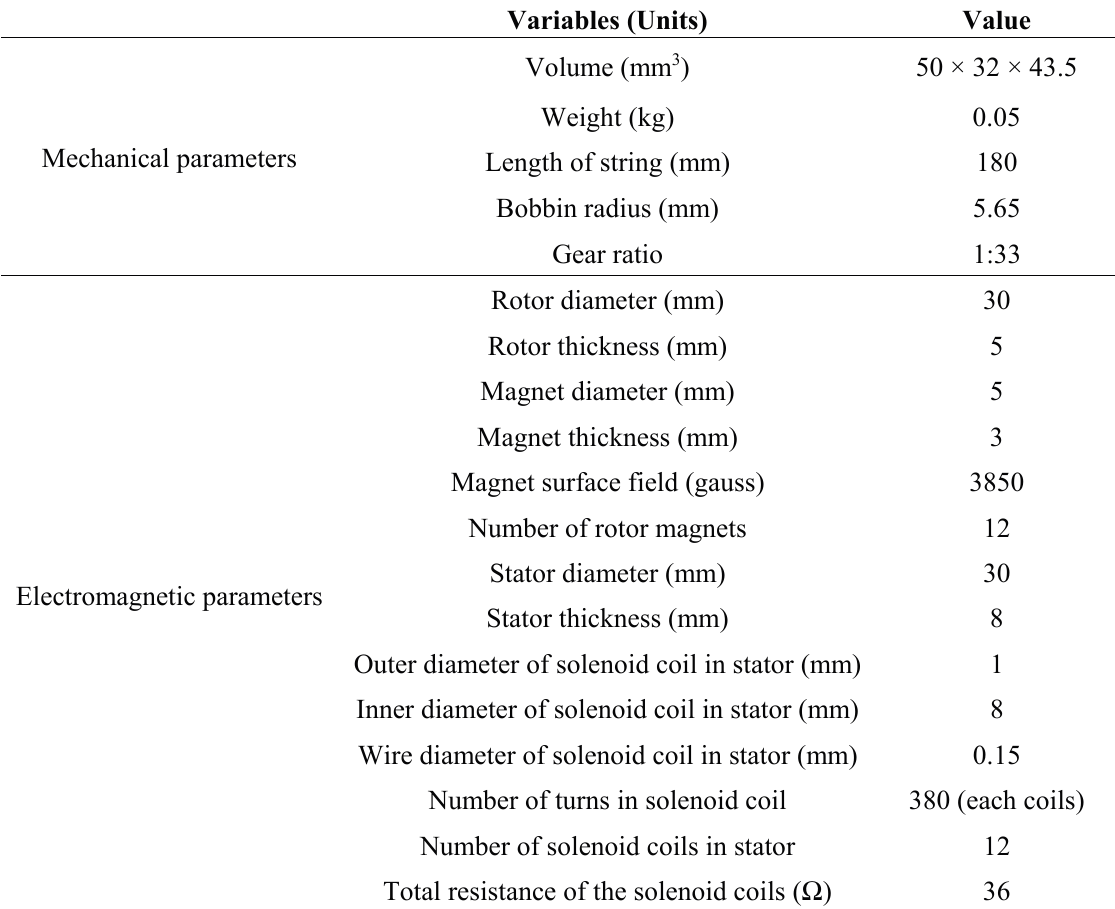
Table 2. Specific parameters of the developed prototype of pulling energy